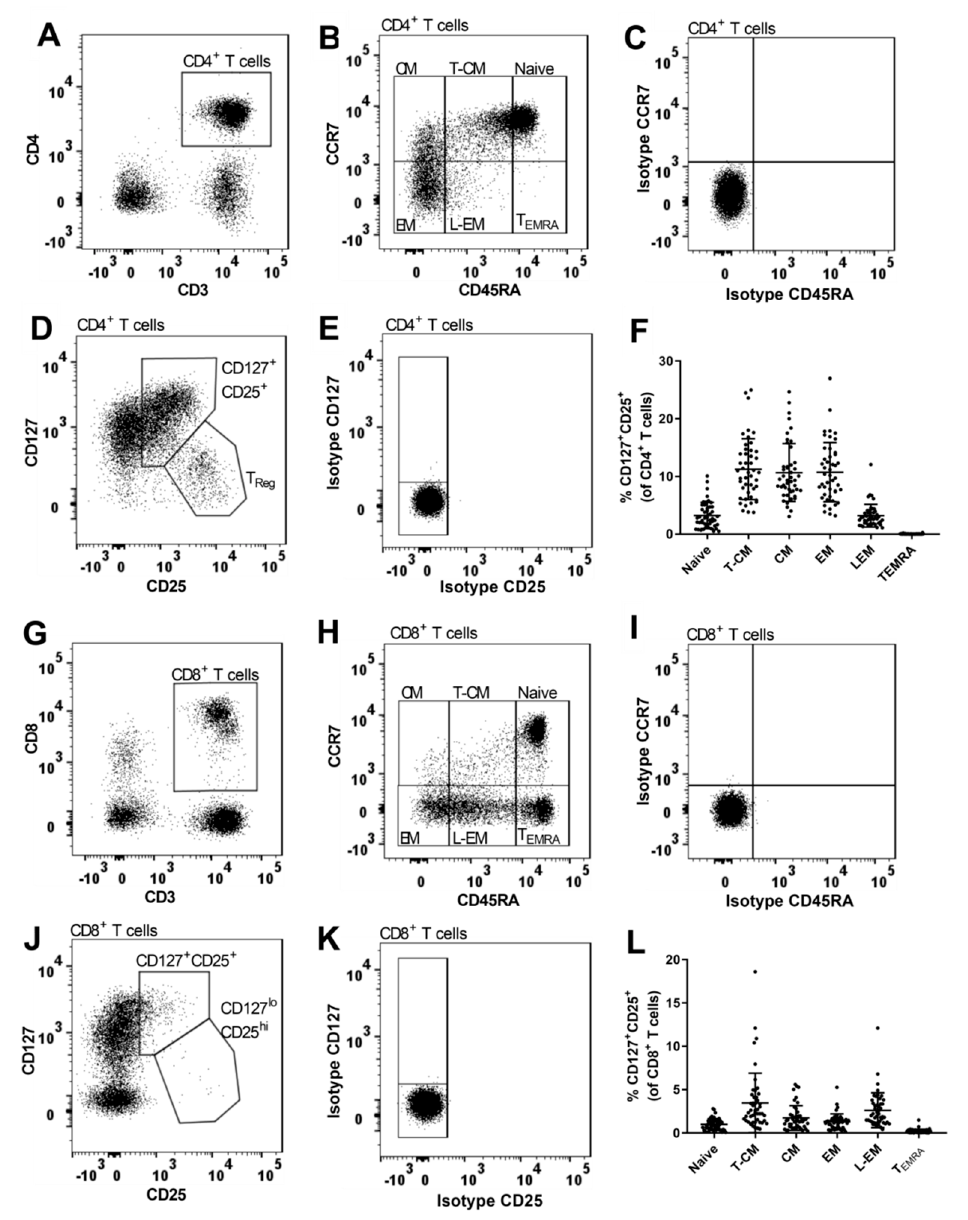
Figure 1. Gating strategy for CD4 + and CD8 + T cell di ff erentiation. ( A , G ) Gating of CD4 + and CD8 + T cells. ( B , H ) Di ff erential expression of CD45RA and CCR7 defines 6 subsets on CD4 + and CD8 + T cells: Naïve (CD45RA hi CCR7 + ), transitional central memory (T-CM) (CD45RA lo-int CCR7 + ), central memory (CM) (CD45RA − CCR7 + ), e ff ector memory (EM) (CD45RA − CCR7 − ), late e ff ector memory (L-EM) (CD45RA lo-int CCR7 − ), and T EMRA (CD45RA hi CCR7 − ). CD45RA hi (Naïve and T EMRA ), and CD45RA lo-int (T-CM and L-EM) were gated on CD8 + T cells (H) and subsequently applied to CD4 + T cells ( B ). CCR7 +/ − and CD45RA − (CM and EM) were gated by use of matched isotype control. ( C , I ) Matched isotype controls for CCR7 and CD45RA on CD4 + and CD8 + T cells. ( D , J ) Di ff erential expression of CD25 and CD127 defines two CD25 + populations on CD4 + and CD8 + T cells: CD127 + CD25 + cells and T Reg (CD127 lo CD25 hi ) cells. ( E , K ) Matched isotype controls for CD25 and CD127 on CD4 + and CD8 + T cells. ( F ) The CD127 + CD25 + gate is applied to the six CD4 + T cell subsets. Frequency of CD127 + CD25 + naïve, T-CM, CM, EM, L-EM, and T EMRA cells in relation to CD4 + T cells. ( L ) The CD127 + CD25 + gate is applied to the six CD8 + T cell subsets. Frequency of CD127 + CD25 + naïve, T-CM, CM, EM, L-EM, and T EMRA cells in relation to CD8 + T cells.